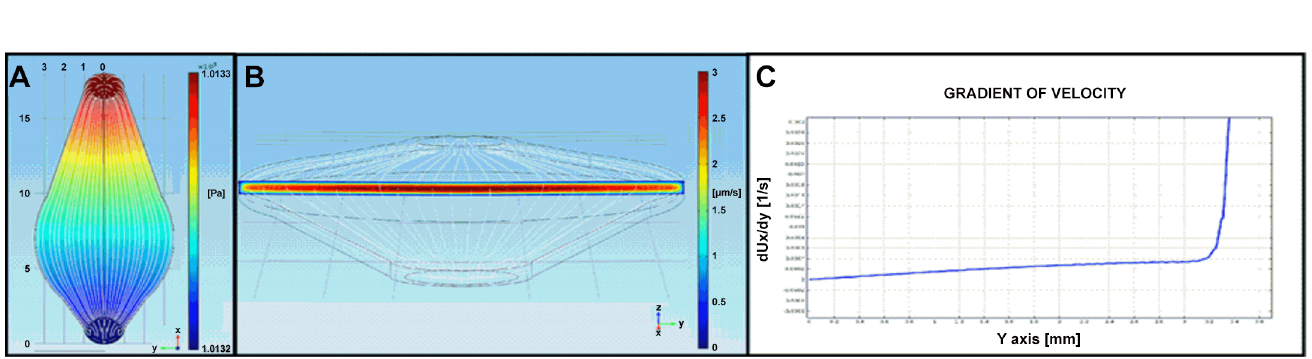
Fig 2. Simulation of the microfluidic flow in the chamber. a: Top view of the results of the simulation of half channel. Stream lines are represented in grey. The colours and the scale bar are relative to the pressure along the channel [Pa]. b: 3D view of the simulated system. Stream lines are represented in grey. A heat map of the values of the x component of the velocity in the widest section of the channel is reported together with the colour scale bar [ μ m/s]. c: Plot of the gradient of the x component of the velocity along the y-axis versus the distance from the centre of the channel.